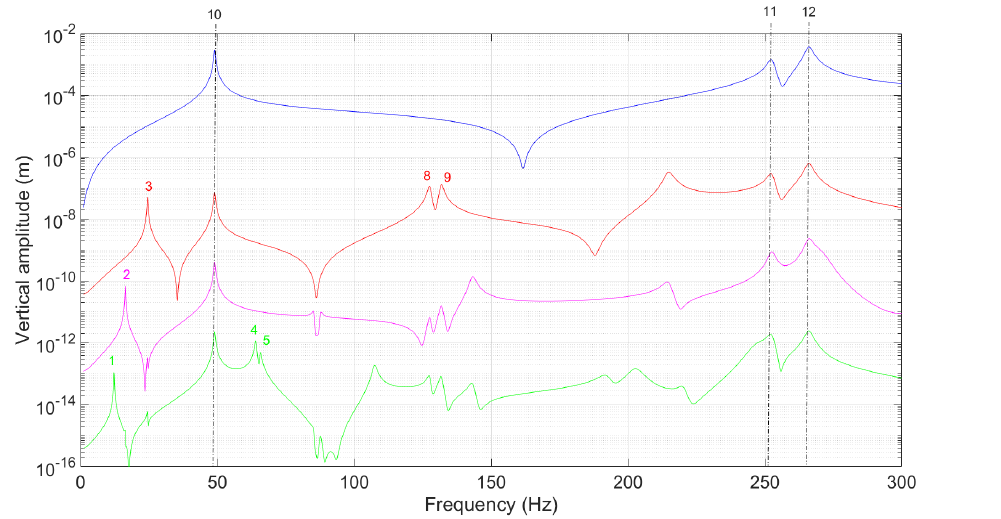
Figure 4. Vertical amplitudes at 0.1 m from the left side of the rotor system with a breathing crack (case 3— µ = 0.1 and L crack = 0.0625 m from the left side) (blue = nonlinear response, black = order 1, red = order 2, magenta = order 3, green = order